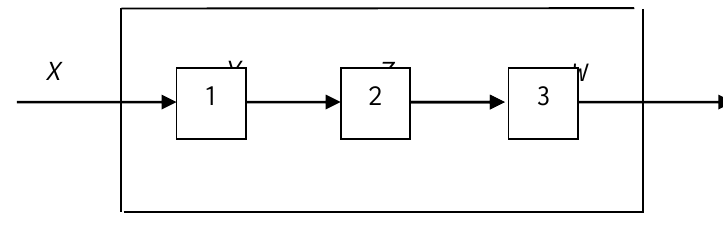
Figure 1: A DMU with three